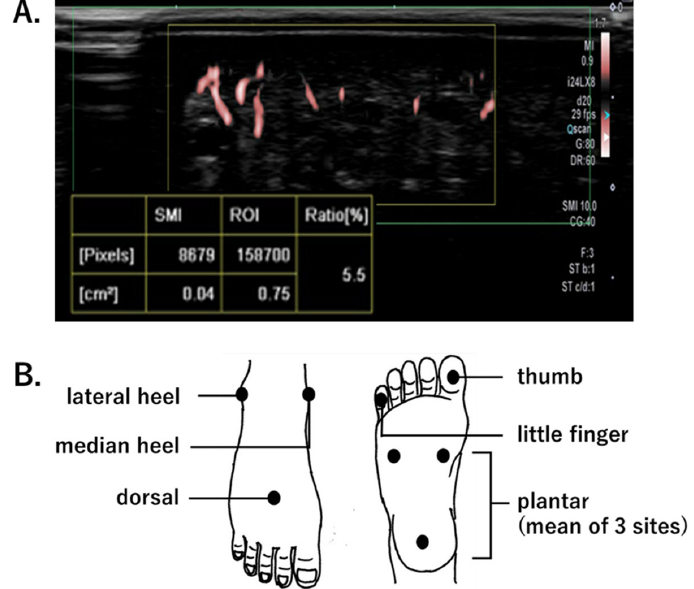
Figure 1. ( A ). Measurement of the superb microvascular imaging ‐ vascular index (SMI ‐ VI), de ‐ fined as the ratio of color pixels (blood flow signals) to the total pixels in the region of interest (ROI). ( B ). SMI ‐ VI measurement points.